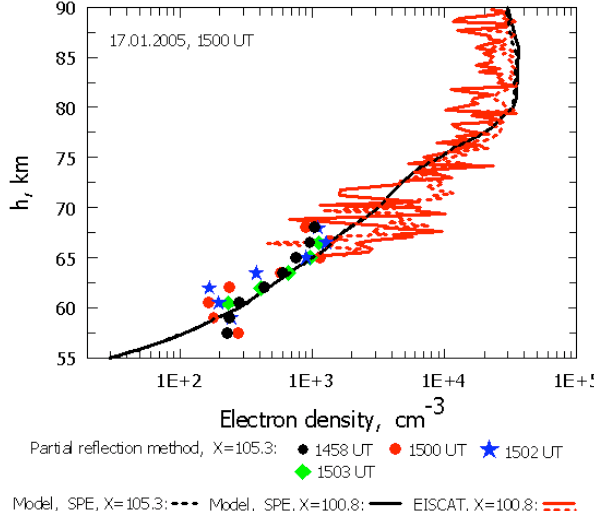
Fig. 11b. Electron density profiles measured (red curve and sym- bols) and calculated for the SPE on 17 January 2005 at 15:00UT for zenith angles 100.8 ◦ and 105.3 ◦ using the O, O 3 and NO pro- files 4–6 in Fig. 1 (black curve).